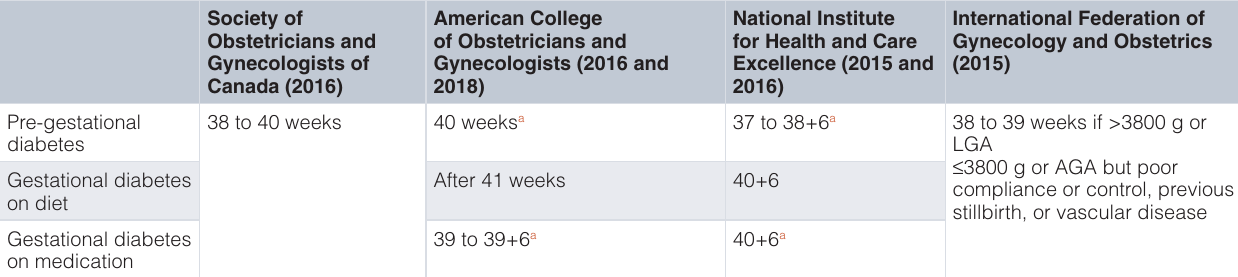
Table 3. Societal guidelines on timing of induction of pregnancies complicated by diabetes. Society of Obstetricians and